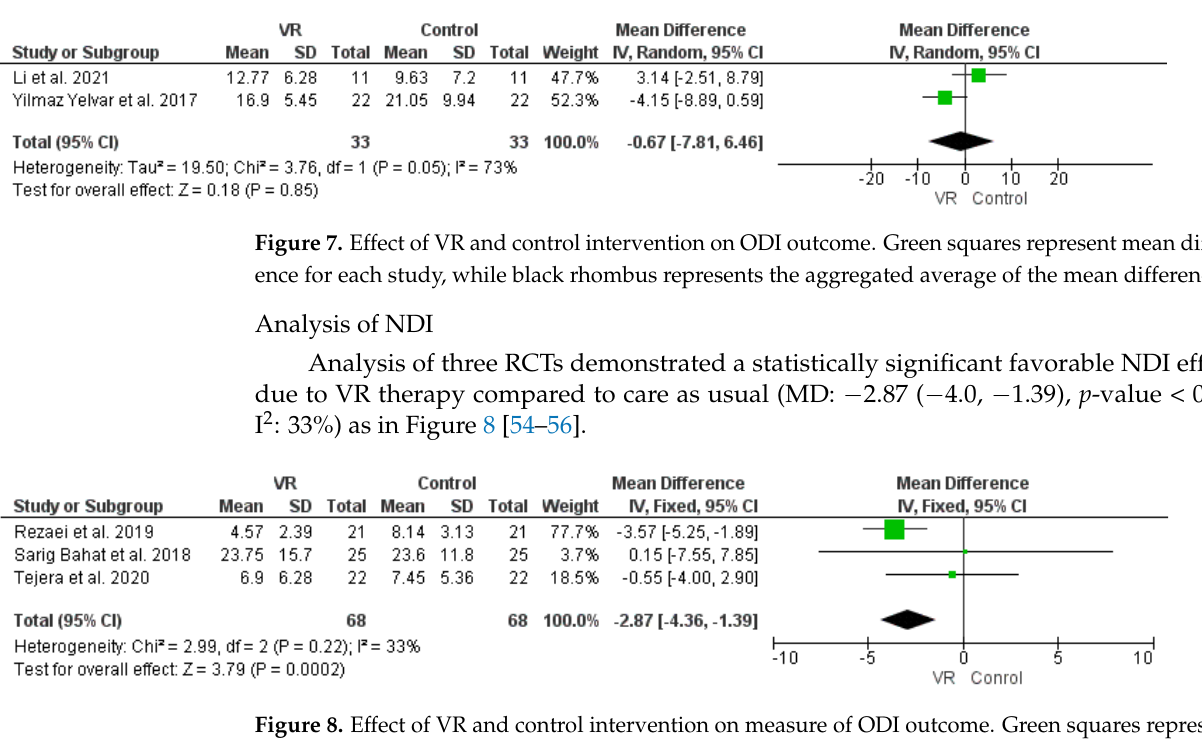
sent mean difference for each study, while black rhombus represents the aggregated average of